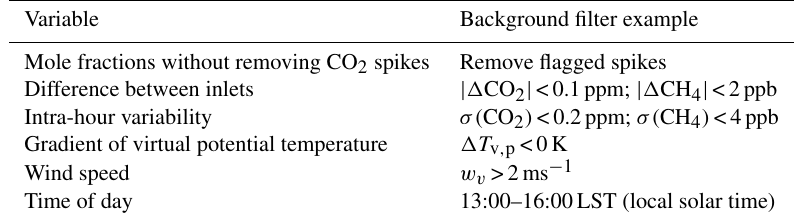
Table 1. Variables for data screening and an example of a strict filter for background conditions that was used to infer average growth rates in Sect. 5.1.